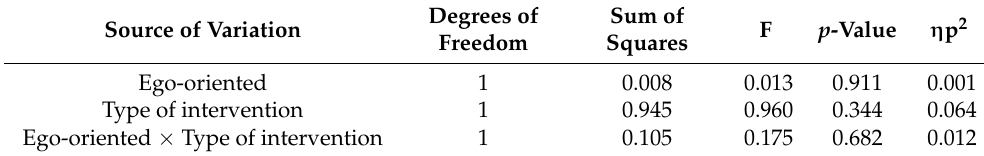
Table 7. Analysis of variance for dependent variable “ego-oriented motivational climate”. Degrees of Sum of F p -Value η p 2 Source of Variation Freedom Squares Ego-oriented 1 0.008 0.013 0.911 0.001 Type of intervention 1 0.945 0.960 0.344 0.064 Ego-oriented × Type of intervention 1 0.105 0.175 0.682